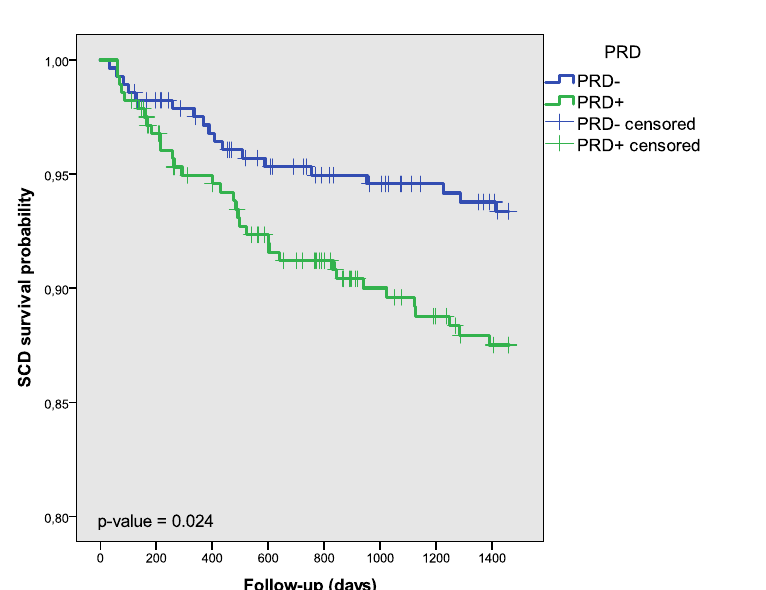
Figure 2. Estimated probability curve of SCD survival for PRD + and PRD −